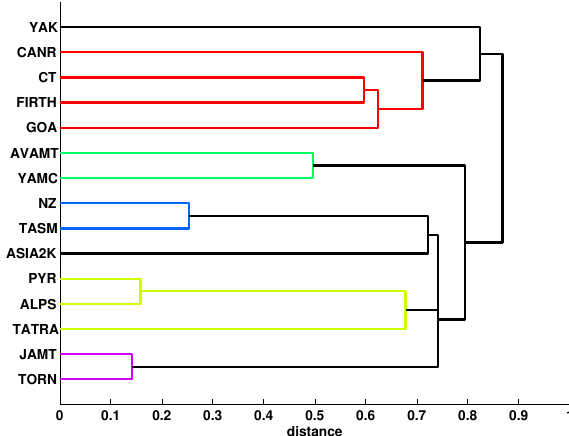
Figure 3. Hierarchical cluster tree based on nearest-neighbour link- age with (1 − r ) as distance metric, where r is the sample correla- tion. Data from the 3000-year-long unforced control simulation, for seasons as specified in Table 1, are used for the cluster